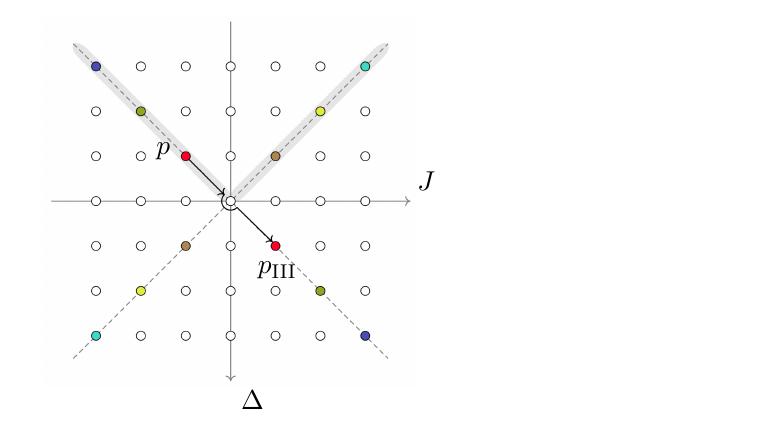
Figure 3. Primary descendants of type III. The dots define the integer lattice Z 2 in the J - ∆ plane. The origin of the lattice is placed at (∆ , J ) = (1 , 0)